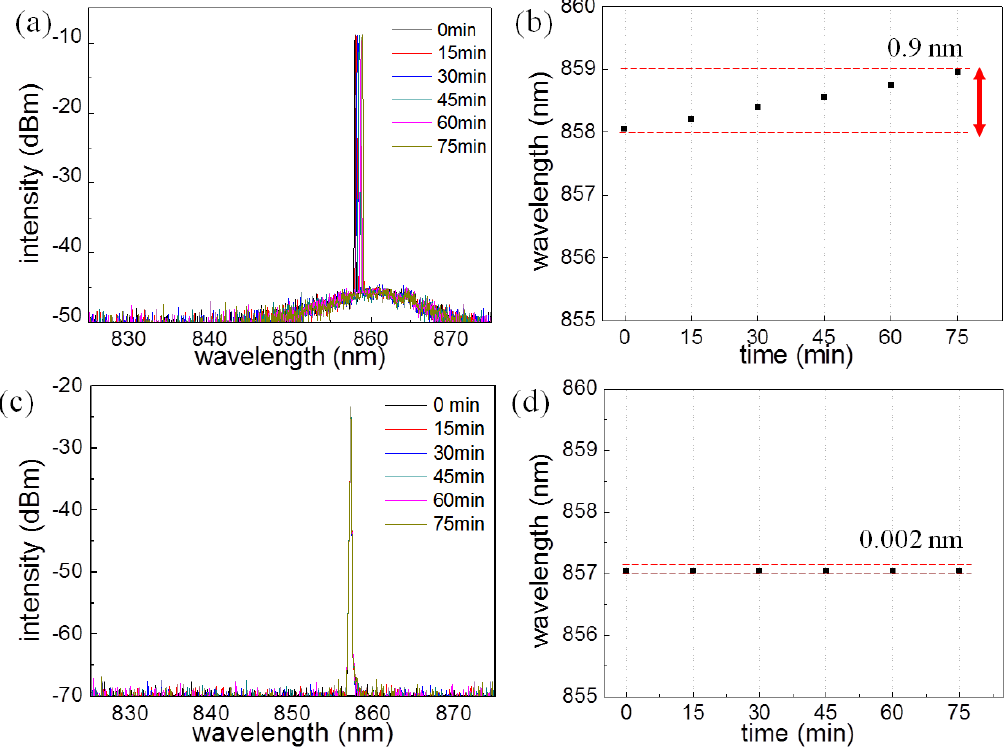
Figure 4. ( a , c ) The output lasing spectra; and ( b , d ) peak wavelength changes at 15 min intervals of